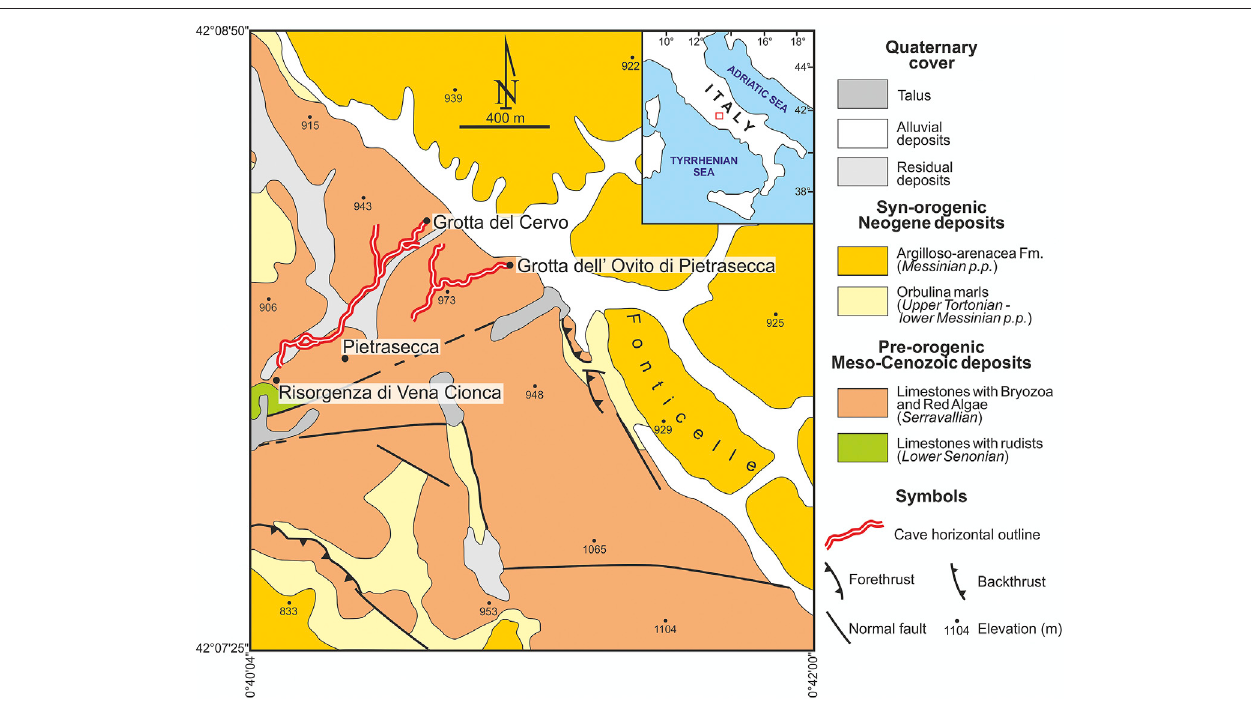
FIGURE 1 | Geological map of the study area, redrawn from Cosentino et al. (1997).